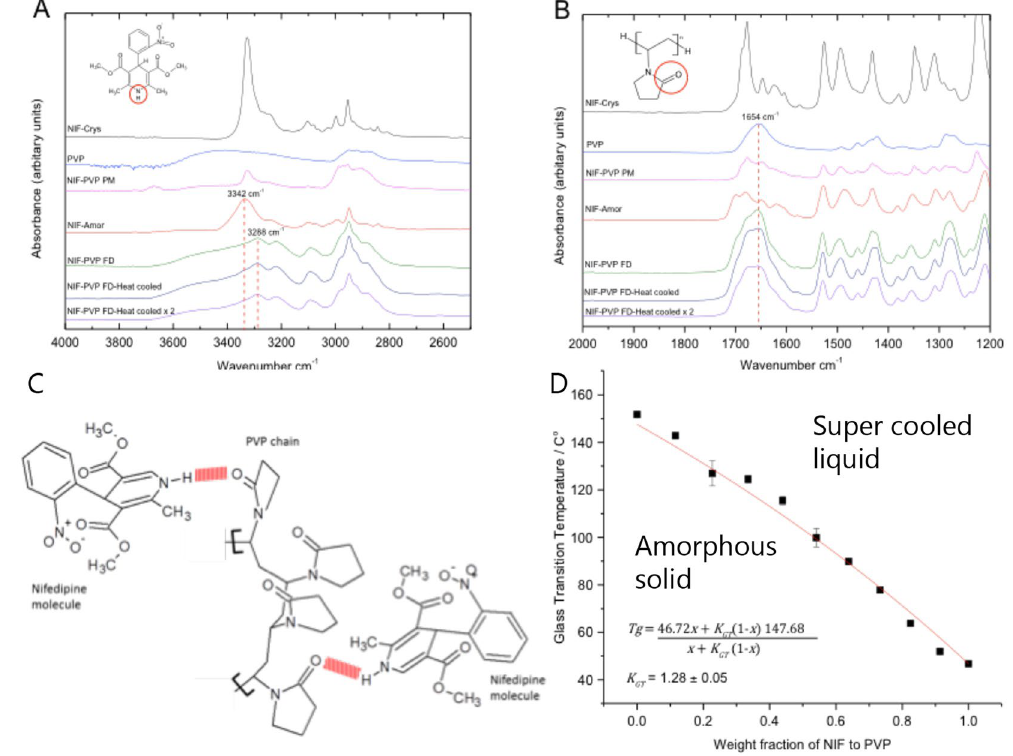
Figure 6. ( A ) FT-IR results show the N-H peak in pure amorphous nifedipine 3342 cm − 1 shifts to 3288 cm − 1 in FD formulations of nifedipine in PVP; thus indicating strong intermolecular hydrogen bonding between the N-H group of nifedipine and the carbonyl group in PVP 37, 49 . (B) Showing the (C = O) carbonyl group of PVP maintained at 1654 cm − 1 in pure PVP and FD formulations: indicating that the C = O peak of PVP was not greatly influenced by the hydrogen bonding between NIF and PVP 37, 49 . FT-IR spectra presented in (A) and (B) were corrected for baseline using the software PerkinElmer spectrum 10. (C) A proposed model for the intermolecular hydrogen bonding between nifedipine and PVP based on the IR spectra. Hydrogen bonds are presented in red. This figure was constructed using ACD/ChemSketch. (D) Average T g of heat cycled samples of nifedipine in PVP. The data was fitted to Gordon Taylor equation, using OriginPro, where x is the weight fraction of nifedipine. Error bars represent standard error of n =